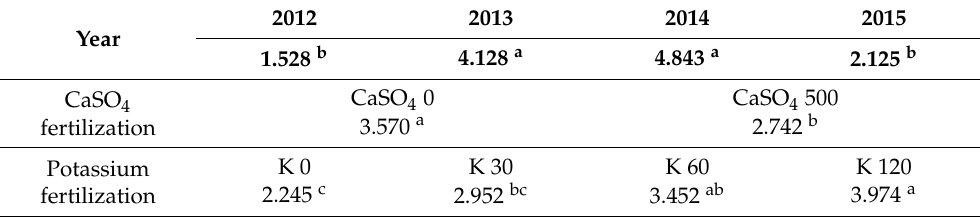
Table 5. Effect of analyzed factors on dehydrogenases activity ( µ mol TPF kg − 1 DM of soil 24 h − 1 ).